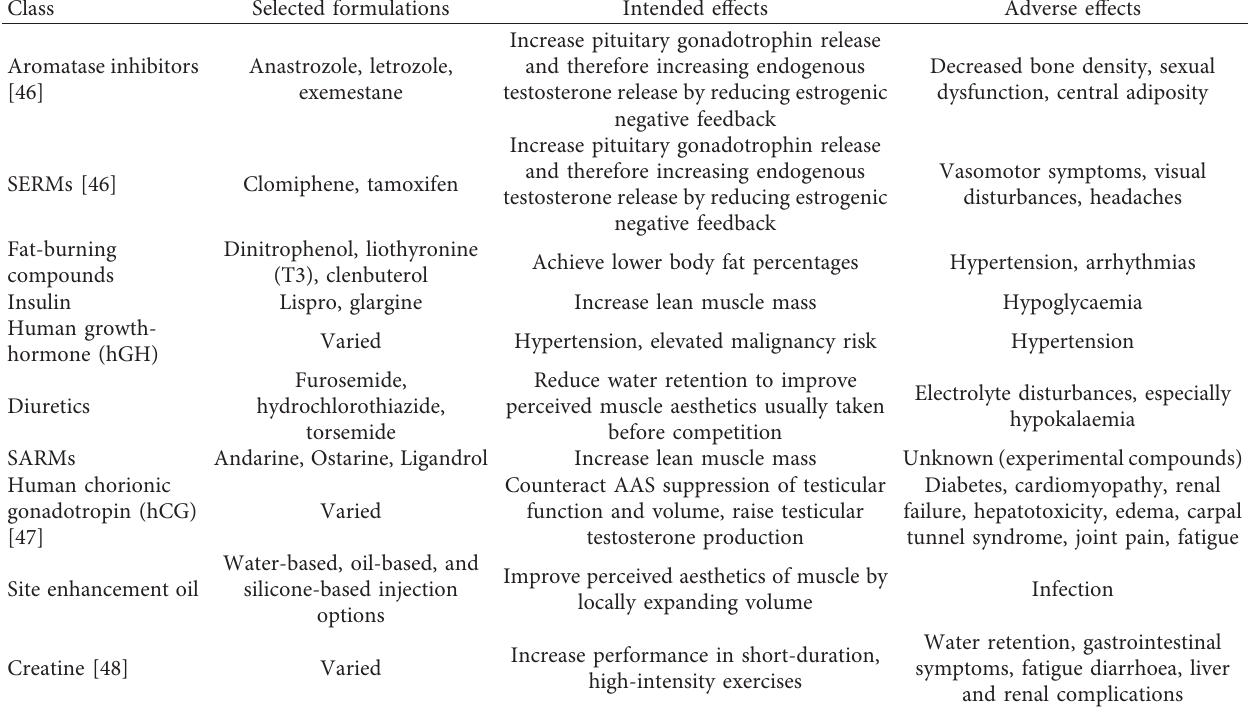
Table 3: Selected performance-enhancing drugs used in relation to AAS.